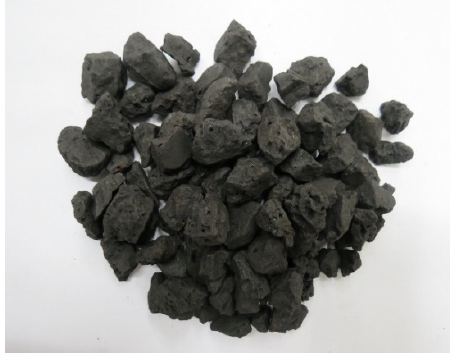
Figure 1. Appearance of steel slag.